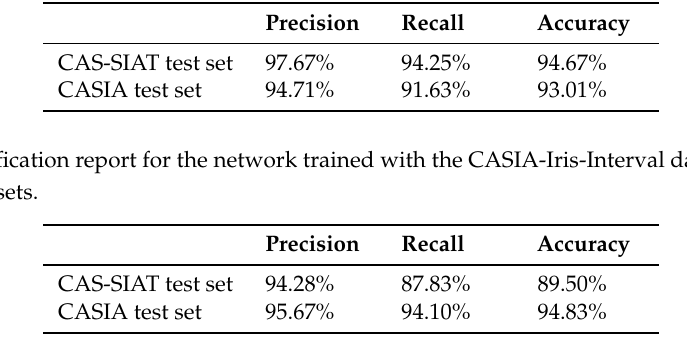
Table 5. Classification report for the network trained with the CAS-SIAT-Iris dataset and tested with both datasets.